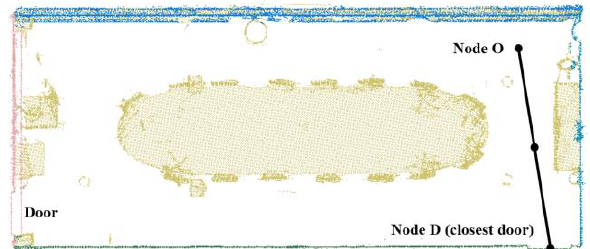
Figure 11: The shortest path for Route C is represented in